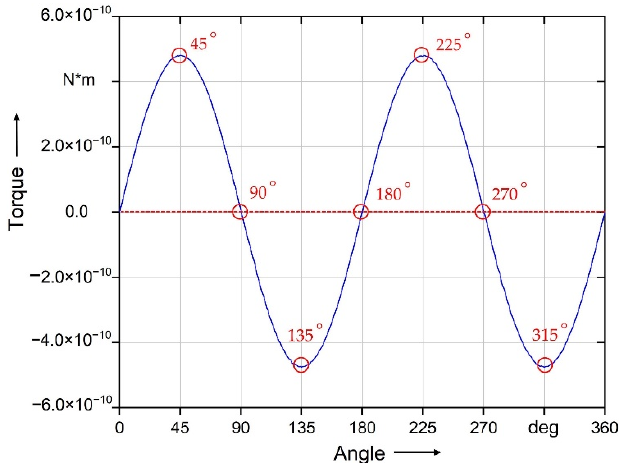
Figure 8. Result of the magnetic torque on the fiber of the short fiber (500 µm) with the coating thickness of 0.2 µm at B 0 = 50 mT.